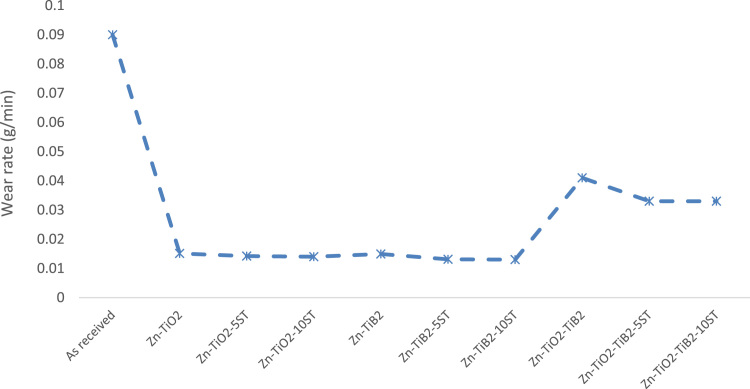
: Experimental trend of variation of TiO2/TiB2/ST on wear properties of mild steel.